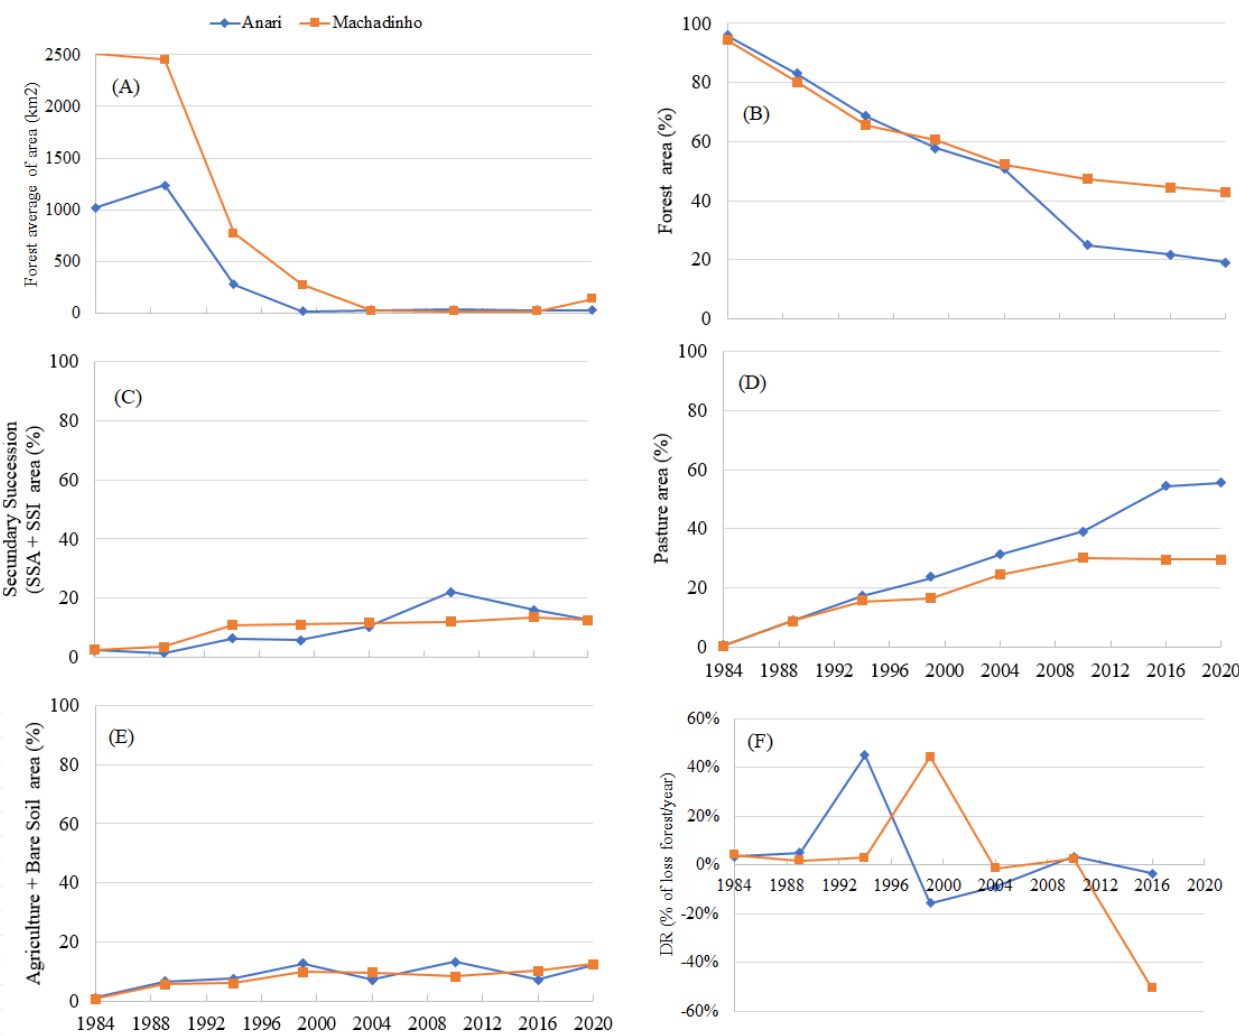
Figure 5. Curve representative of the forest fragmentation ( A ) as per average of forest area, ( B ) forest cover and advance of occupation (%) with Secondary Successions (SSA & SSI) ( C ), pasture ( D ), bare soil and agricultural ( E ) areas in the settlements of Machadinho and Anari (1984 to 2020) and Deforestation rate (% of loss forest/year) ( F ).